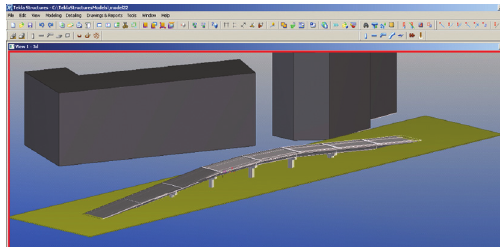
Fig. 4. Site boundaries representation in Tekla structures